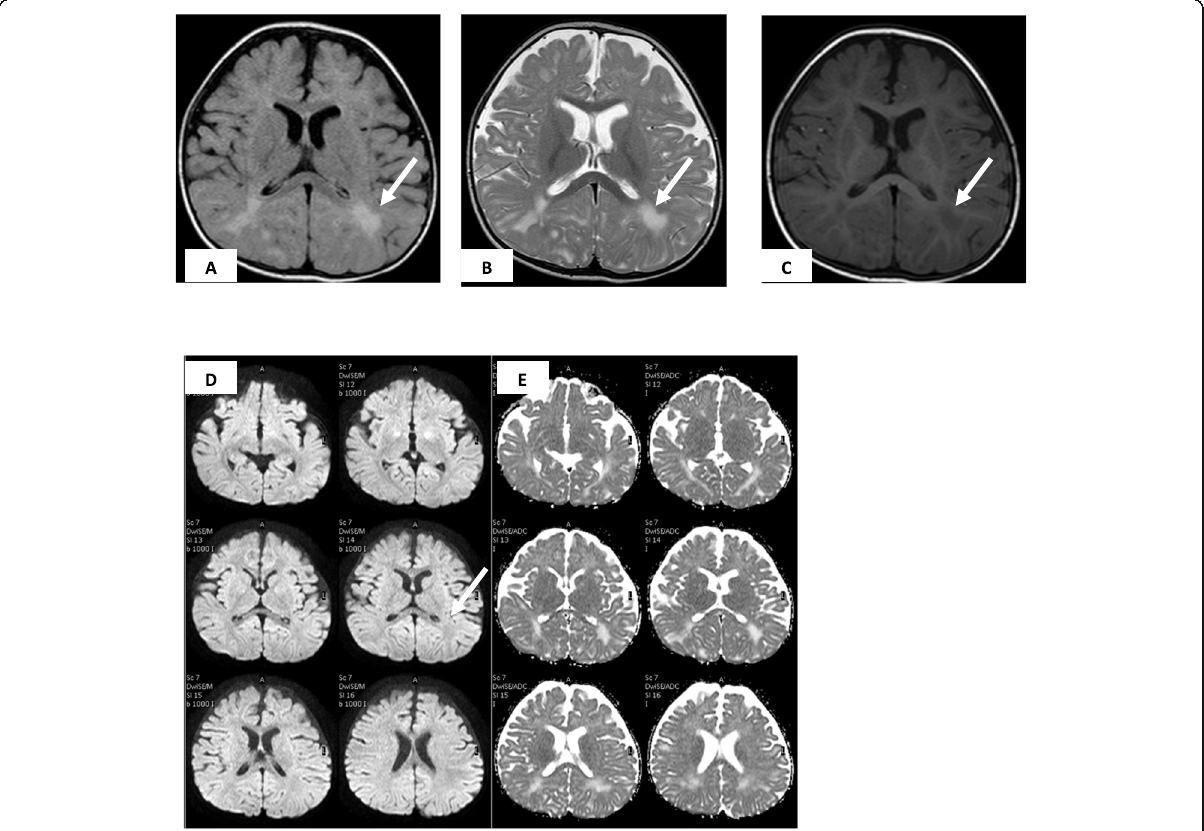
Fig. 1 Nine-month-old girl, PICU admitted for prolonged asphyxia with diagnosis of mild HII . MRI done 8 days after admission showing bilateral symmetrical areas of abnormal signal involving the juxta-cortical, subcortical and periventricular white matter (white arrows) .They elicit low/ intermediate signal on T1 ( C ) and high signal on T2 ( B ) and FLAIR ( A ) with no restricted DWI ( D,E ) “ pseudonormalization ” although neurologically